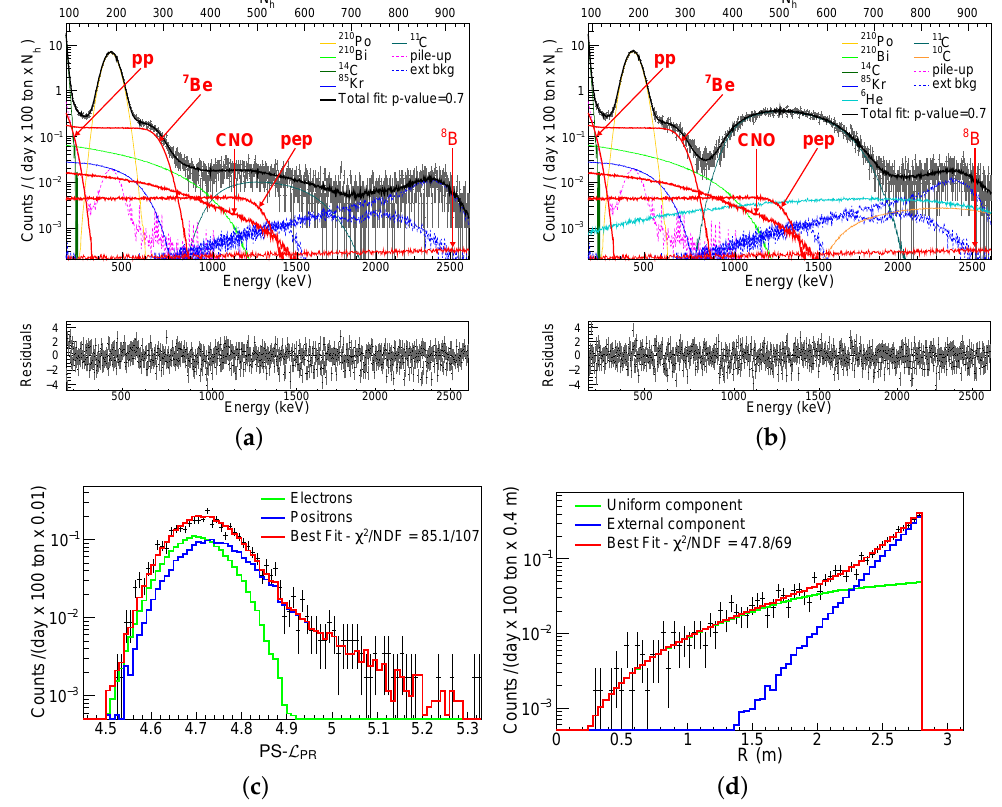
Figure 5. Multivariate fit of Borexino Phase II data in LER, using MC-based method and N h energy estimator. The solar neutrino species are shown in red. The total fit p -value is 0.7. ( a ) Spectral fit of the TFC-subtracted ( 11 C depleted) energy spectrum. ( b ) Spectral fit of the TFC-tagged ( 11 C enriched) energy spectrum. ( c ) Fit of the pulse-shape variable. ( d ) Fit of the radial distribution of events. From